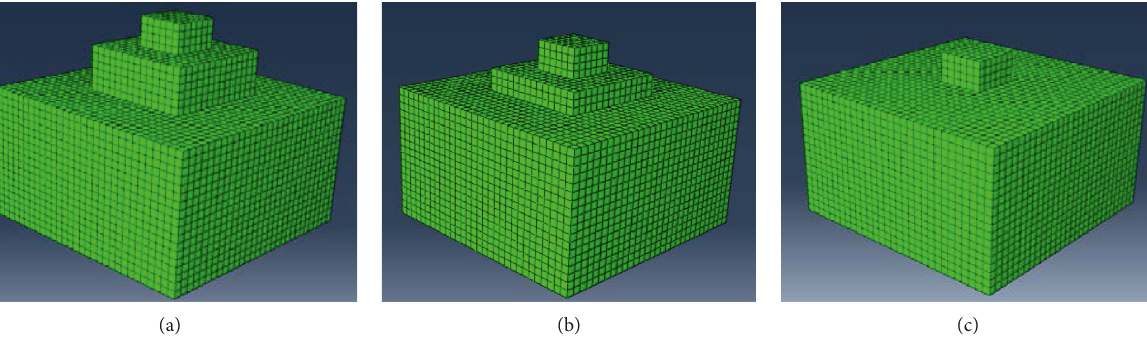
Figure 4: Concrete footing-soil models. (a) Footing not embedded. (b) Half of the footing is embedded. (c) Full of the footing is